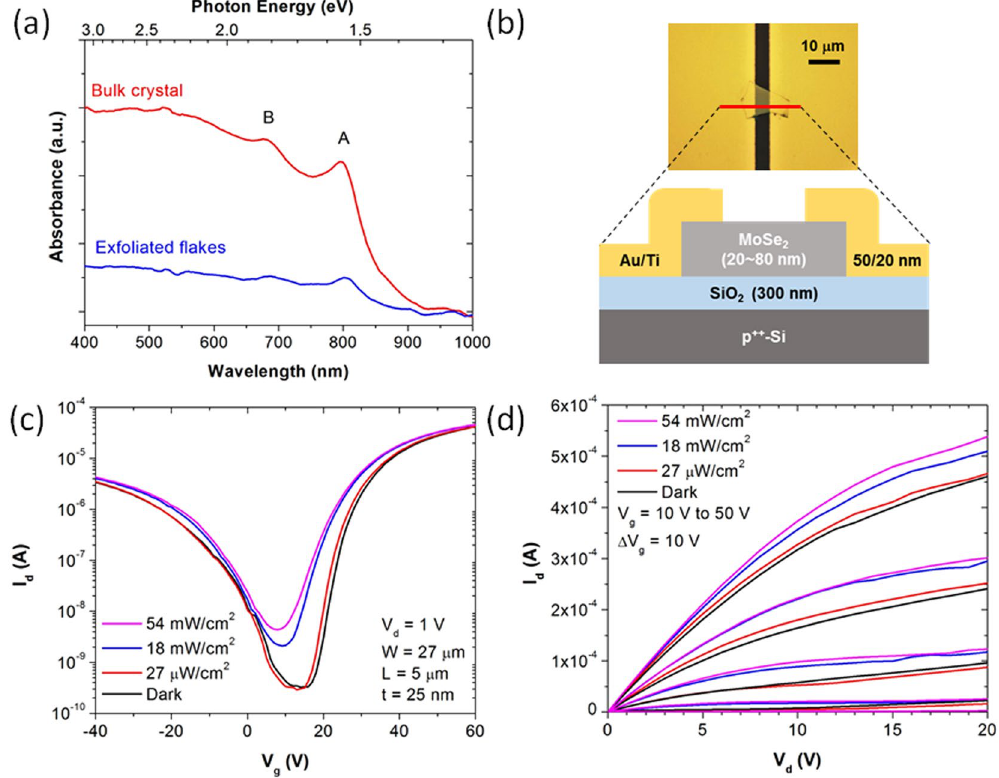
Figure 1. ( a ) Absorbance spectra of MoSe 2 crystals and mechanically exfoliated flakes on sapphire with two excitonic peaks A and B, ( b ) optical microscopy image and schematic cross-section of an MoSe 2 phototransistor along the red line, ( c ) I d − V g and ( d ) I d − V d characteristics of an MoSe 2 phototransistor with different optical power of incident